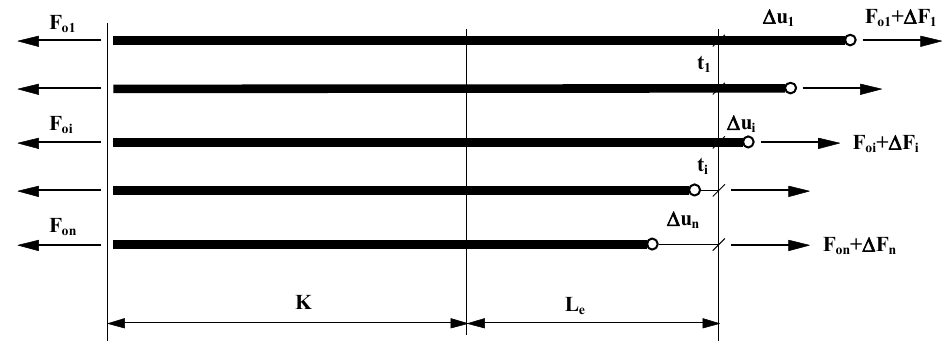
Figure 5. Schematic diagram of loads acting on cables in the transition section.